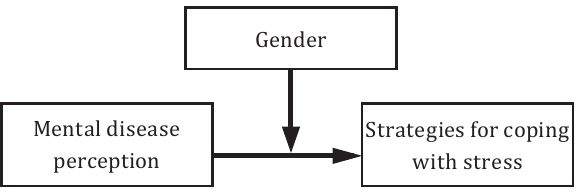
Figure 1. The theoretical model of gender role in the relationship between the mental disease perception and strategies for coping with stress